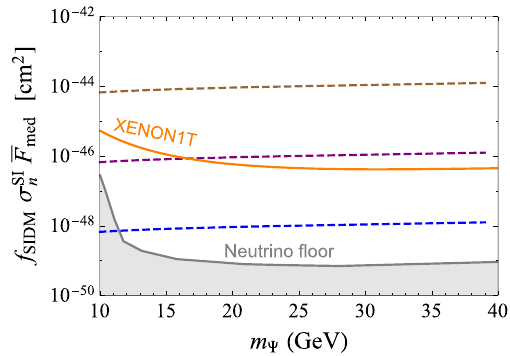
Fig. 5 The reference factor ¯ F med as a function of SIDM mass m (cid:3) in SIDM–target nucleus ( 131 Xe) SI elastic scattering. The solid curve is the result of ¯ F med , with SIDM mass in a range of 10–39 GeV and m φ = 20 MeV. Here the range of the recoil energy E R and the detection efficiency (cid:18)( E R ) in XENON1T (2018) experiment [9] are adopted as inputs. For comparison, the dashed line is for the case ¯ F med = 1